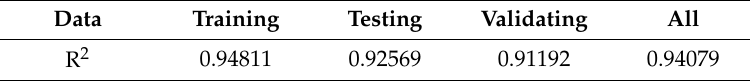
Table 4. Characteristics of the ANN model for the second